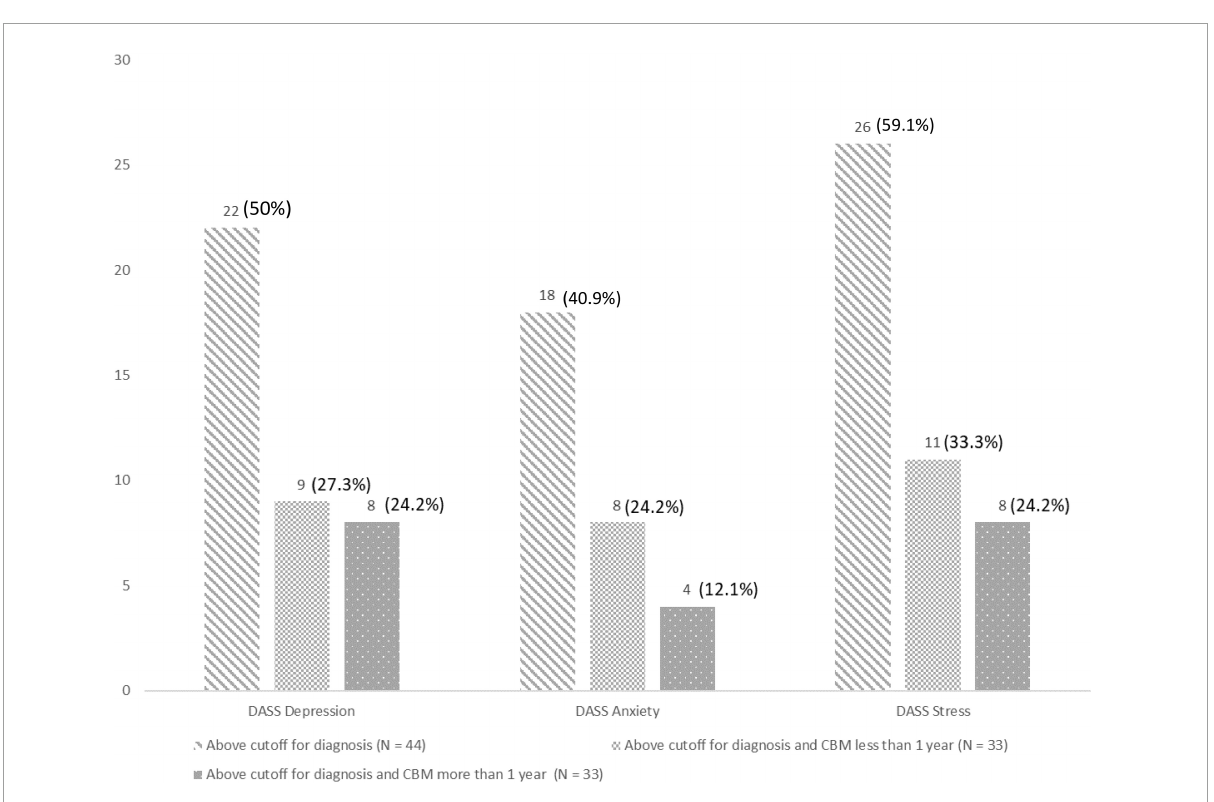
FIGURE5 Results of the depression anxiety atress scale (DASS) in terms of the depression, anxiety, and stress subscales for the sample overall and in relation to the duration of cannabis-based medicine (CBM) treatment (i.e., less or more than a year).